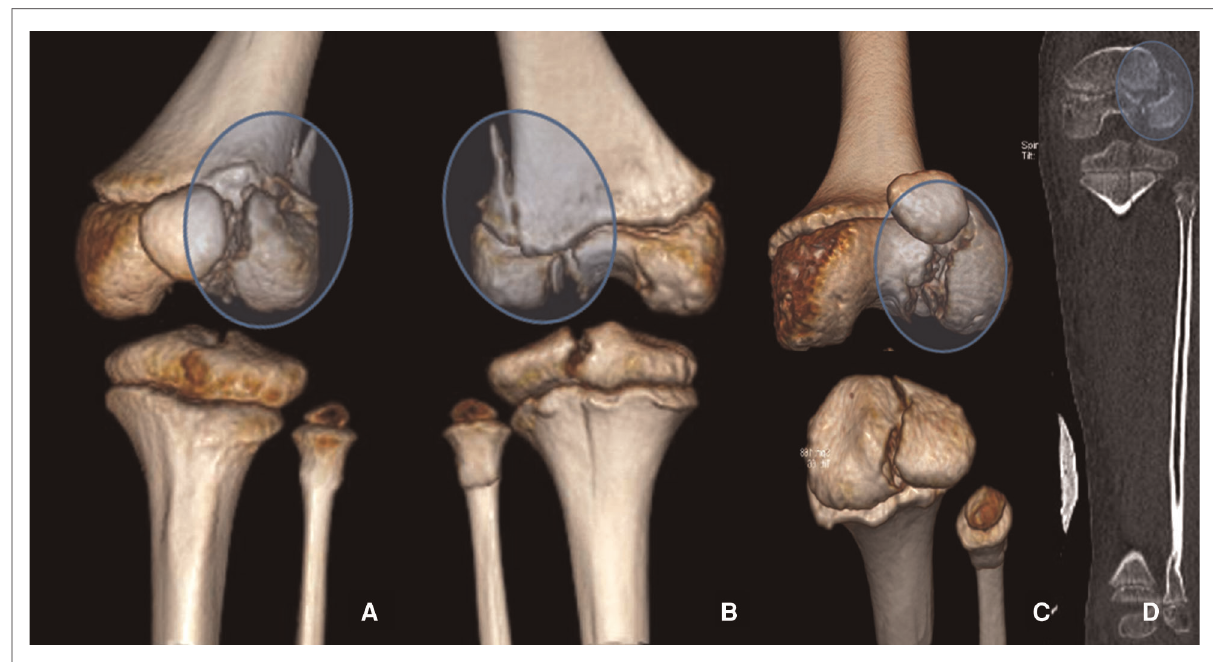
FIGURE 1 3D CT reconstruction of physis injuries of the left knee in anterior view ( A ), in posterior view ( B ), inlet view ( C ), and 2D CT coronal view ( D